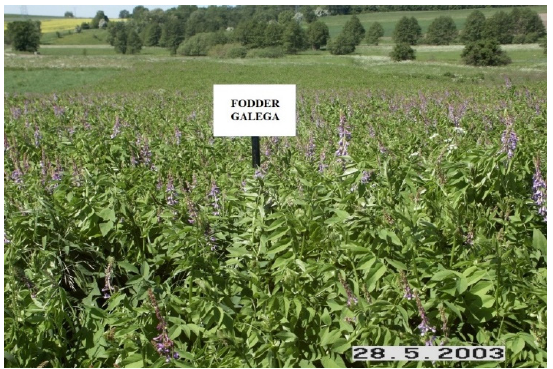
Figure 1. Fodder galega in late May ( Ż arczy ń ski